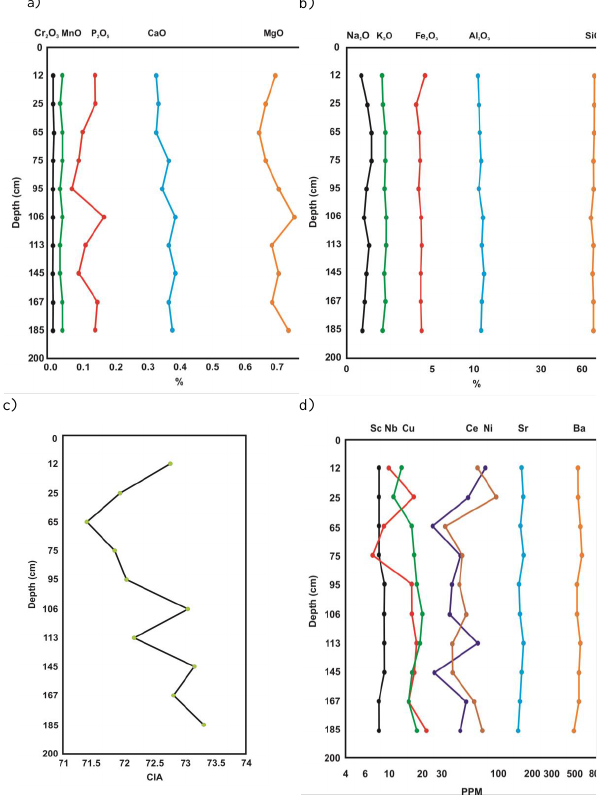
Figure 5. Profile distribution of the geochemical elements